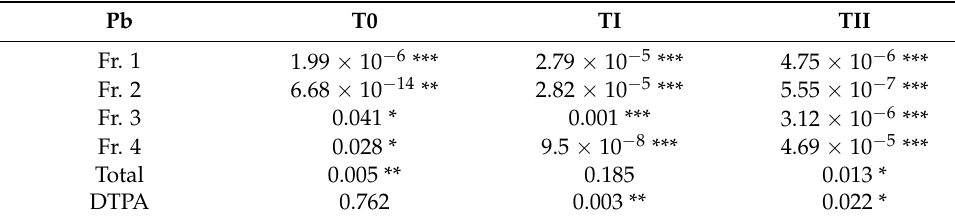
Table 2. p -values from one-way ANOVA determined separately for different Pb fractions: Fr. 1–4, Total and DTPA in soil depending on amendment (compost or fly ash): T0—control soil, TI—soil with compost addition and TII—soil with FA addition. Comparison between years.